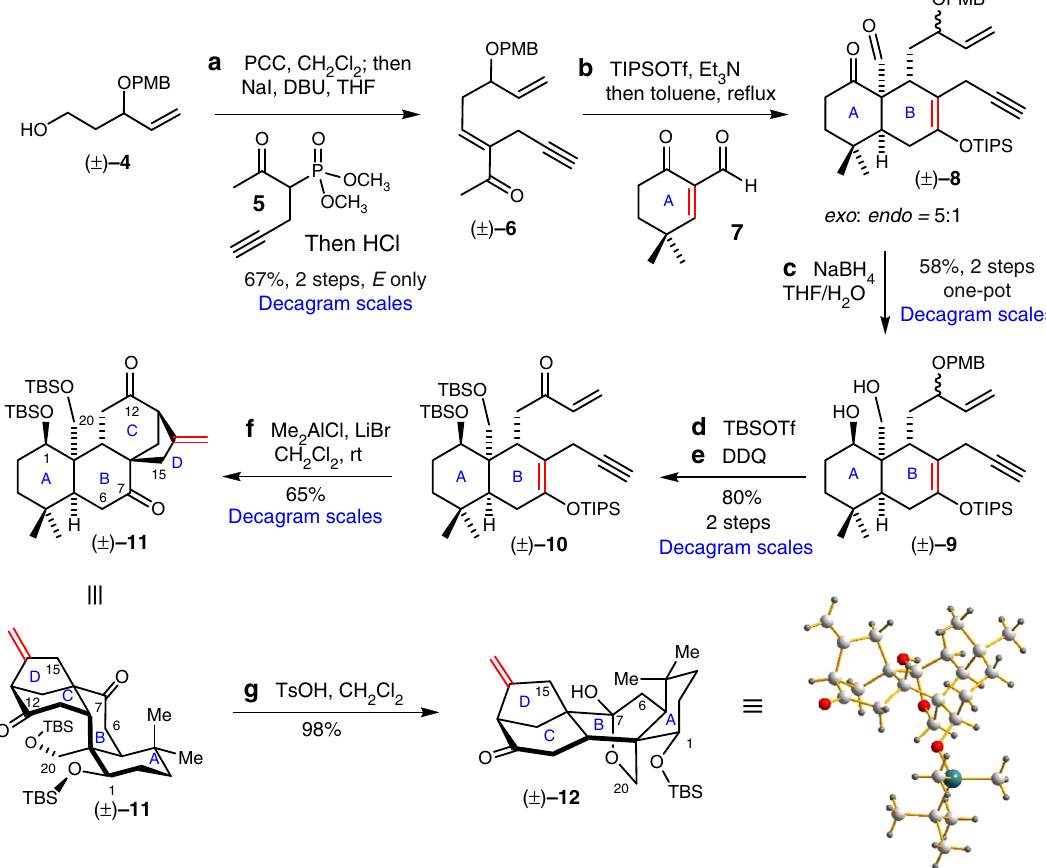
Fig. 3 Synthesis of the tetracyclic core. The tetracyclic core of (±) − 11 was established via an iterative ene-type cyclization strategy from readily available substrates (±) − 4 , 5 and 7 in seven steps with 20% overall yield. The synthetic route can be operated in decagram